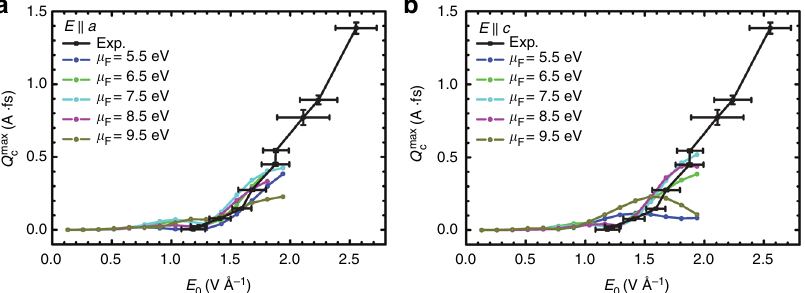
Fig. 5 Dependence of the net transferred charge on the position of the Fermi energy. N = 6 junctions are constructed along the a a -direction and b c - direction. Experimental values and error bars (standard deviation) are taken from ref. 4 . Note that the results are insensitive to the position of the Fermi energy, except when μ F is chosen to be close to the top of the VB (as in μ F = 5.5 eV) or to the bottom of the CB (as in μ F = 9.5 eV) (cf. Fig.